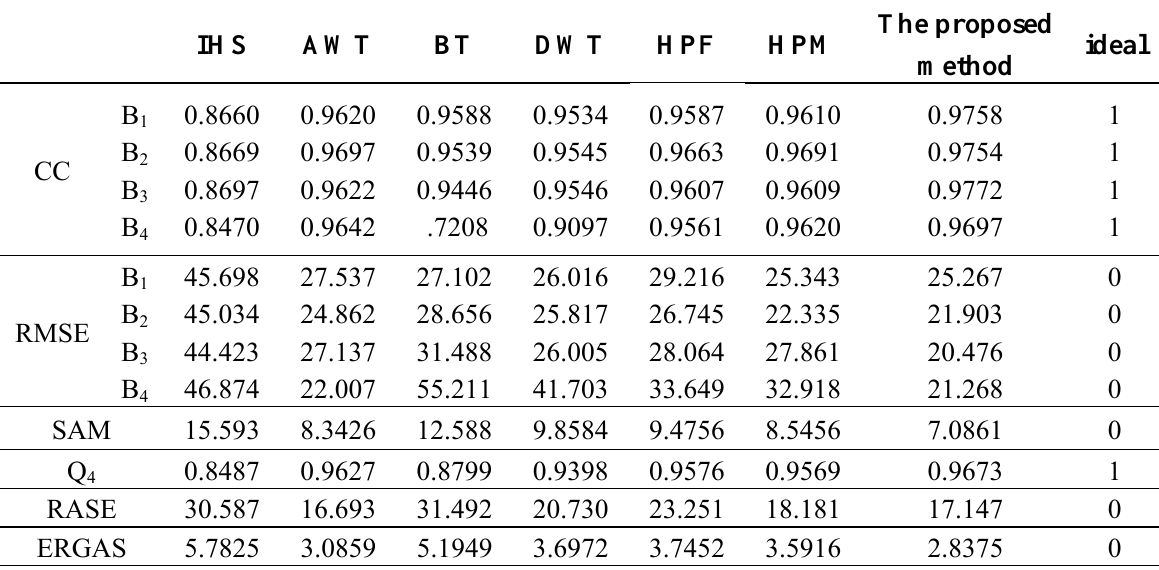
Table 2 . Values of the six indexes analyzed to evaluate the qualities of